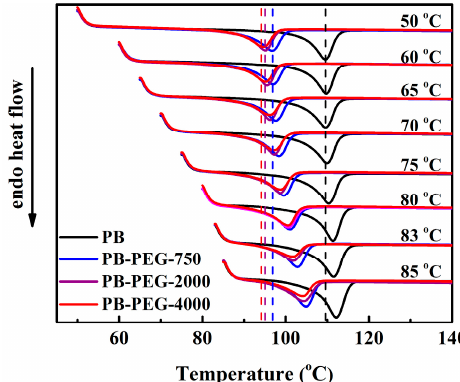
Figure 5. DSC melting curves of PB and PB-PEG crystallites prepared by isothermal crystallization at different temperatures. The thermal protocol was illustrated in Figure S3b.